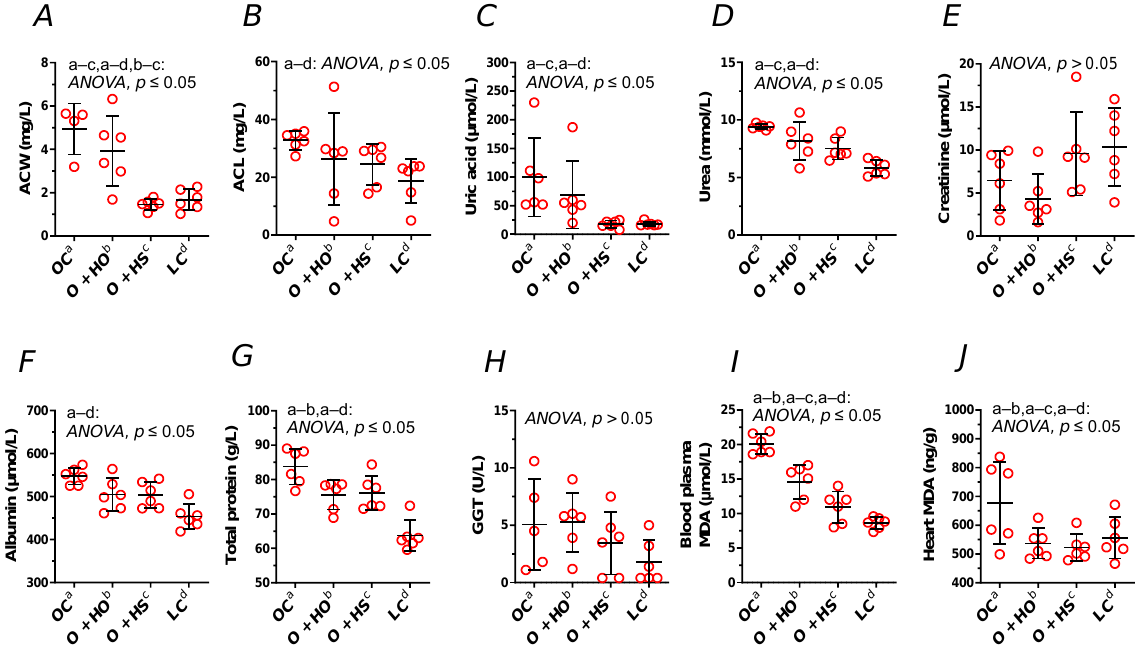
Figure 4. Blood plasma analysis ( A – I ) and heart malondialdehyde ( J ) of 8-week-old lean (LC) and obese (OC) Zucker rats fed a diet containing hemp seed oil (HO) and hemp seeds (HS) for 4 weeks. Values are means ± SD, n = 6, p ≤ 0.05 (two-way ANOVA). ACW is a marker that distinguishes HO from HS. ACL, antioxidant capacity of lipid-soluble compounds; ACW, antioxidant capacity of water-soluble compounds; MDA, malondialdehyde.